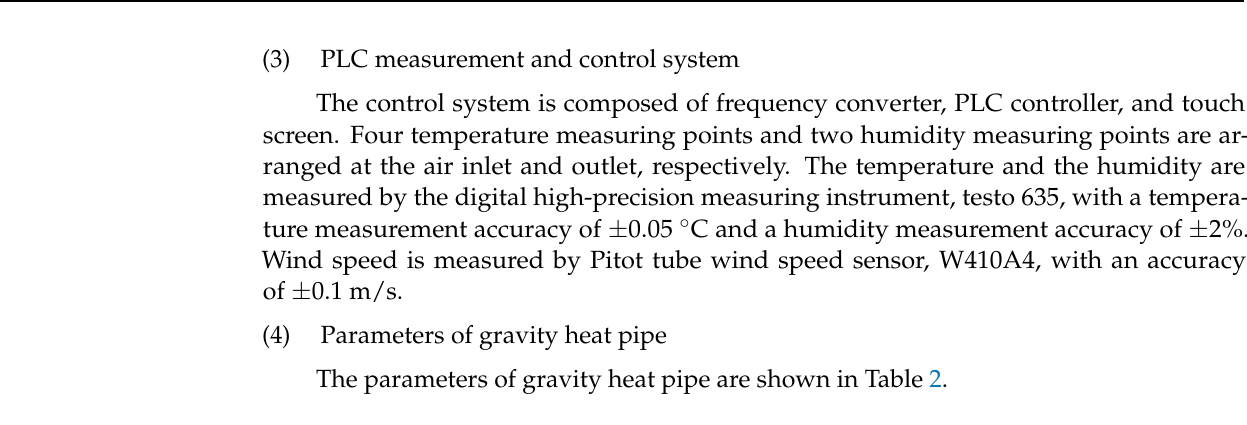
Table 2. Parameters of gravity heat